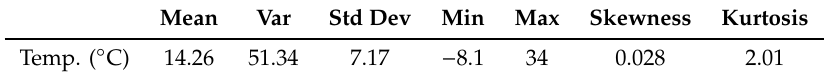
Table 1. Descriptive Statistics of the daily average temperature in Arezzo (Tuscany) 1970–2016. Mean Var Std Dev Min Max